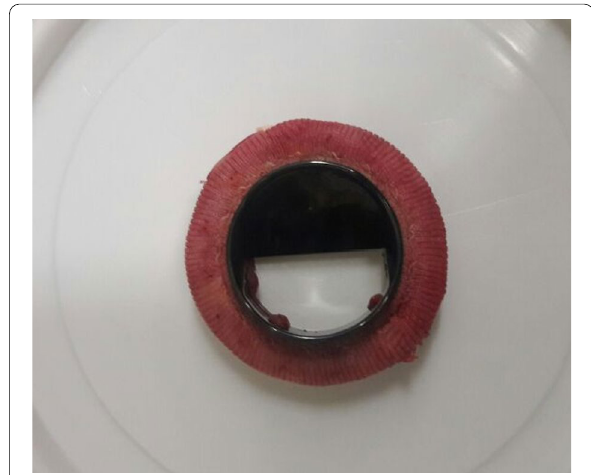
Fig. 3 The explanted mechanical mitral valve prosthesis On-X with a single